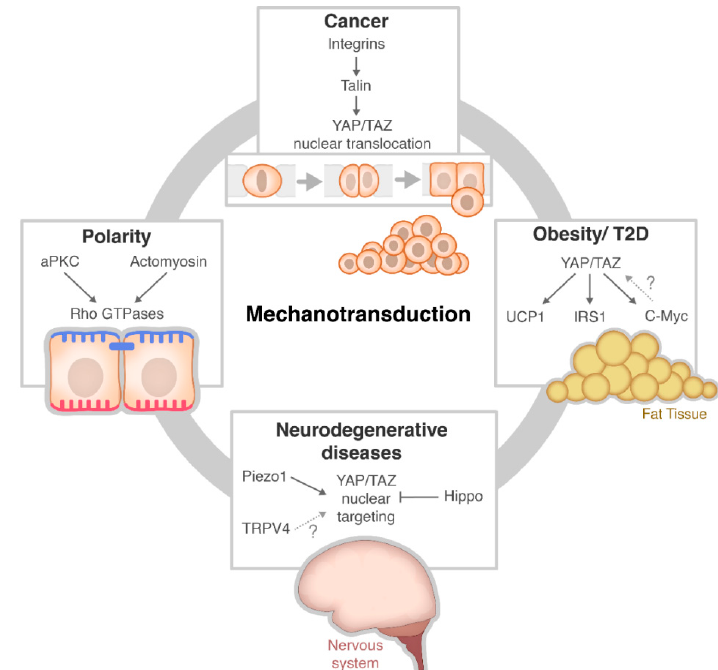
Figure 2. The pathways and interplay with regulate mechanotransduction in the context of chronic disease and polarity. Note that some pathways are not well established and thus represented by a question mark (?) (T2D = Type 2 Diabetes). Please note also ⟶ = activates and —| = inhibits.